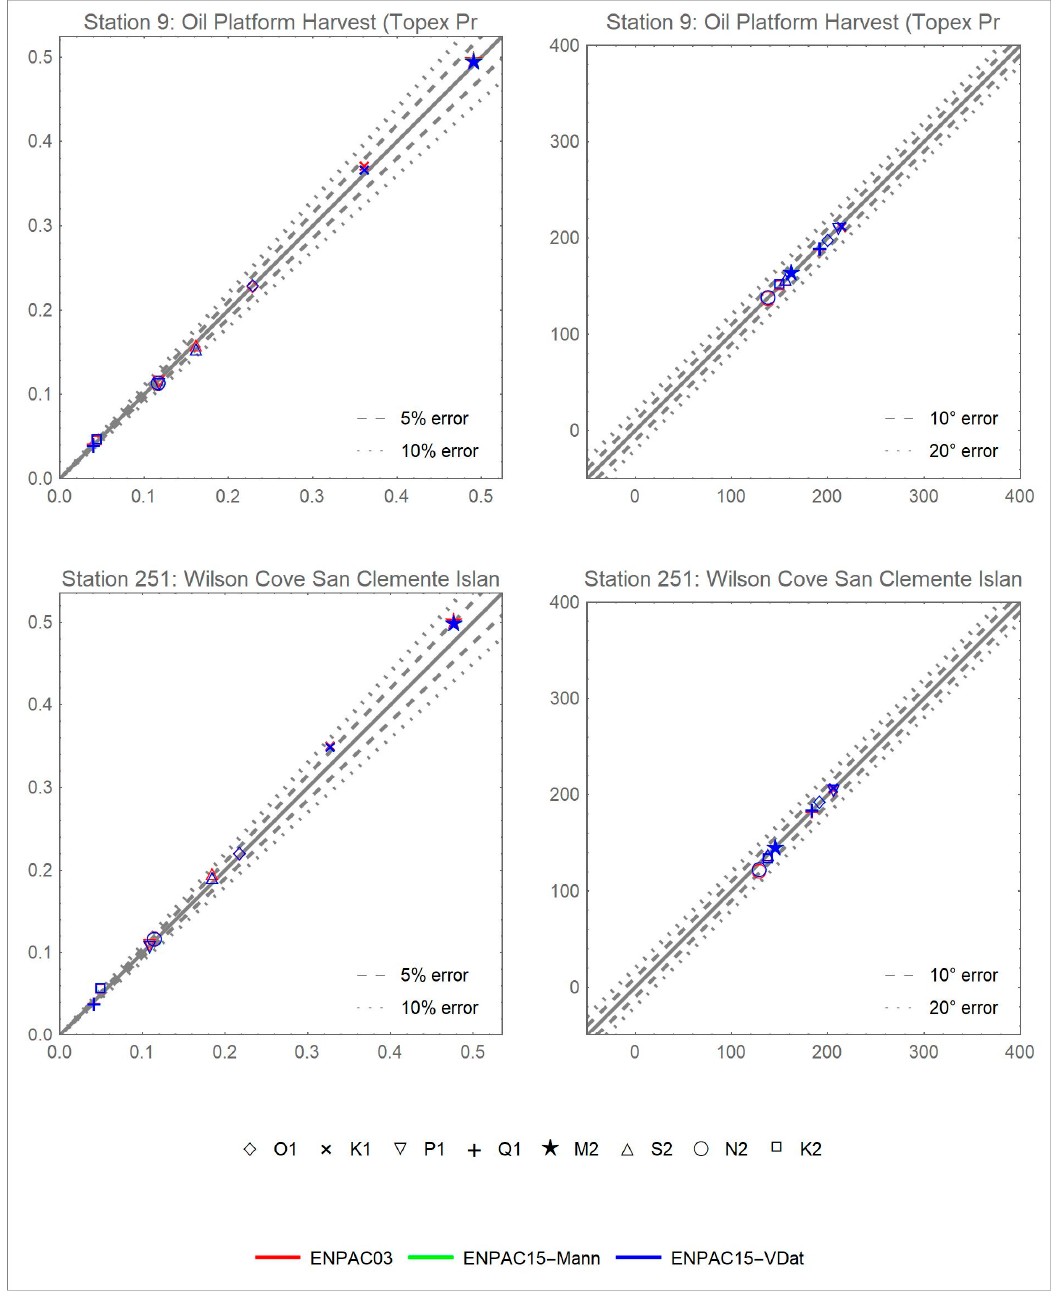
Figure A6. Scatterplots of errors for two Southern California stations, locations shown in Figure A1.